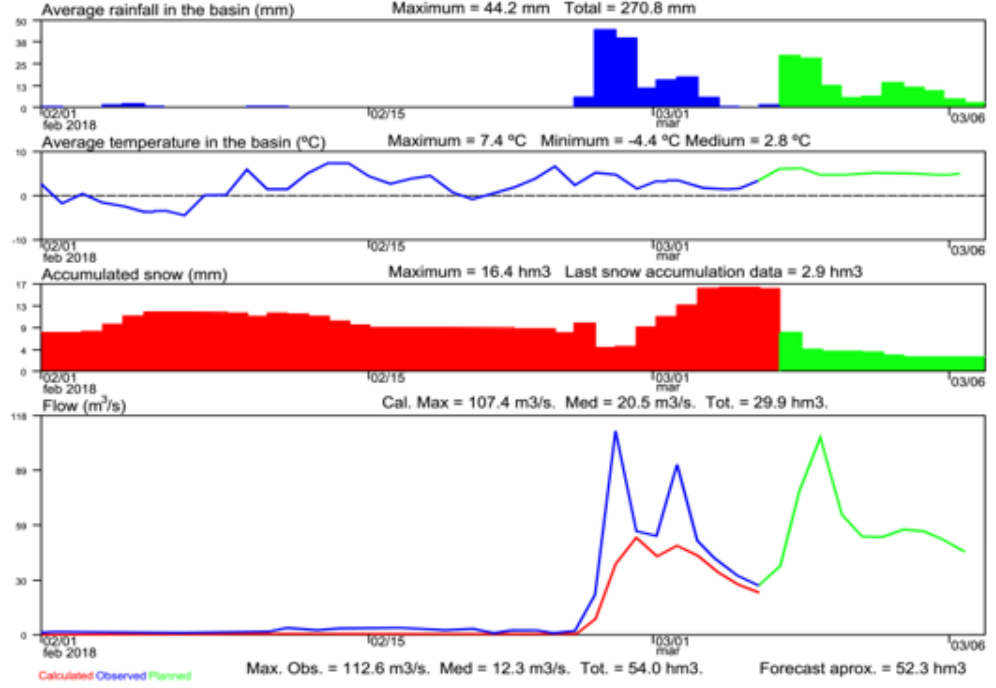
Figure 12. Flow forecast graph (green) in the El Burguillo reservoir, with the AEMET (most probable) temperature and rainfall predictions.